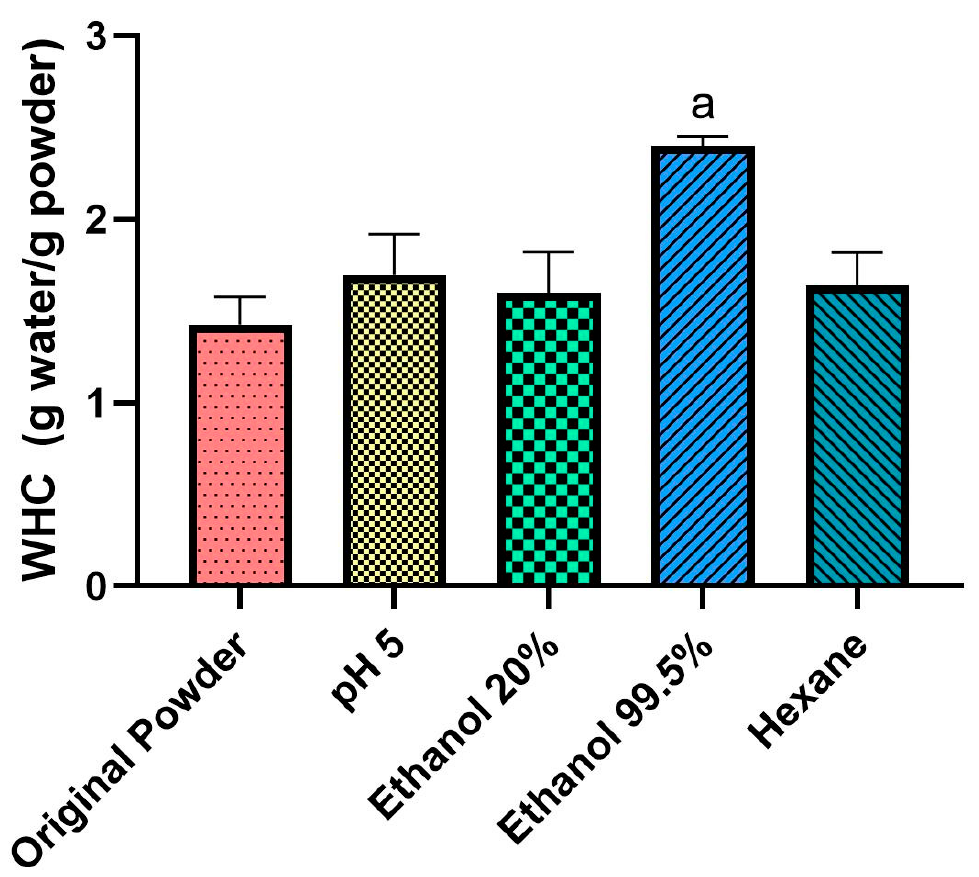
Figure 6. Water-holding capacity (WHC) before and after treatments in cricket powder. Letters represent significant difference ( p < 0.05). a = ethanol 99.5% vs. all the powders.